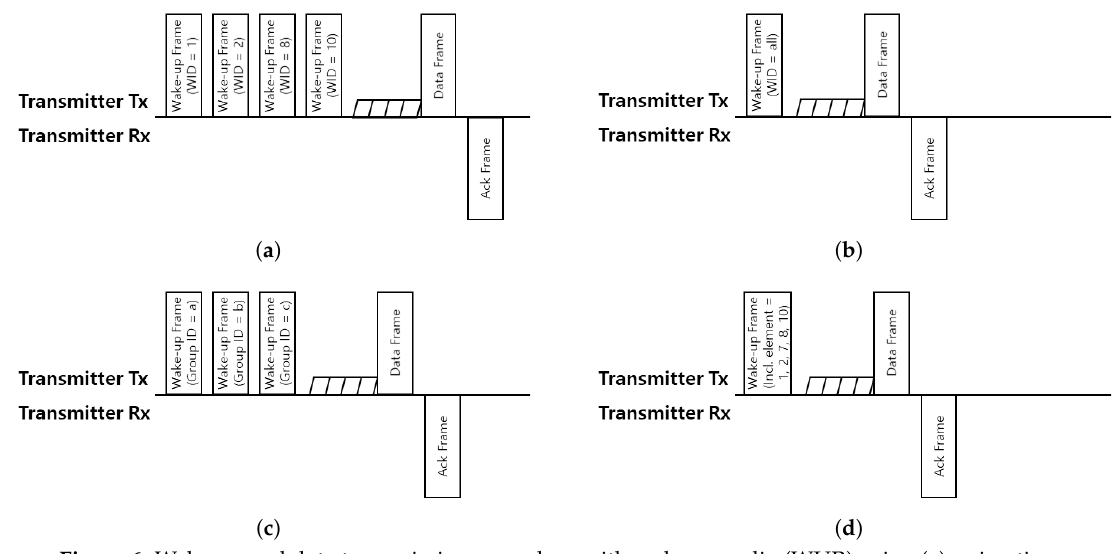
Figure 6. Wake up and data transmission procedure with wake up radio (WUR) using ( a ) unicasting, ( b ) broadcasting, ( c ) groupcasting and ( d ) Bloom filter. The transmitter wakes up recipients based on each addressing method and transmits data frame to